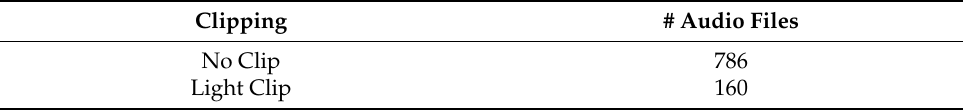
Table 1. Number of audio files according to their clipping